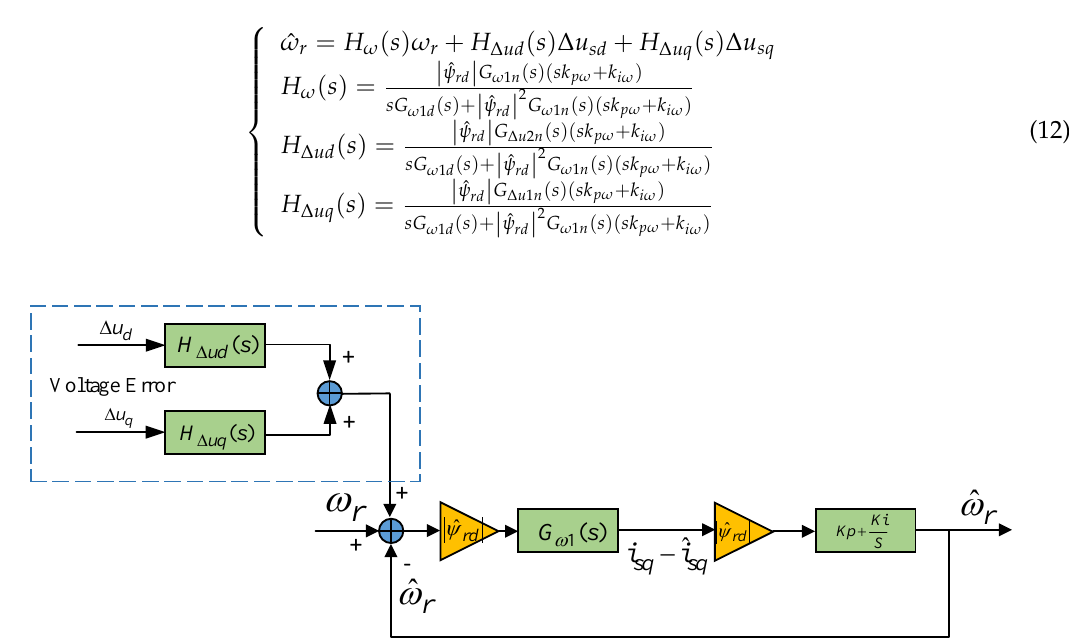
Figure 8. The general configuration of the model reference adaptive systems.